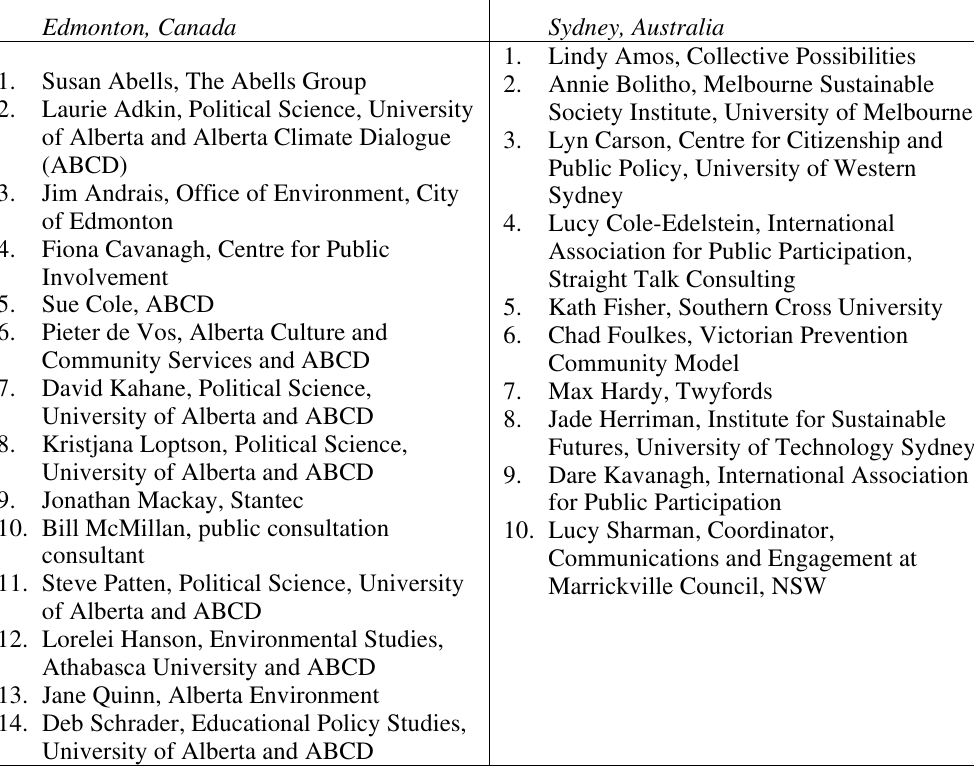
Table 1 —Participants in the virtual Australia–Canada workshop on stakeholder and citizen roles in democratic deliberation (names and affiliations as of date of